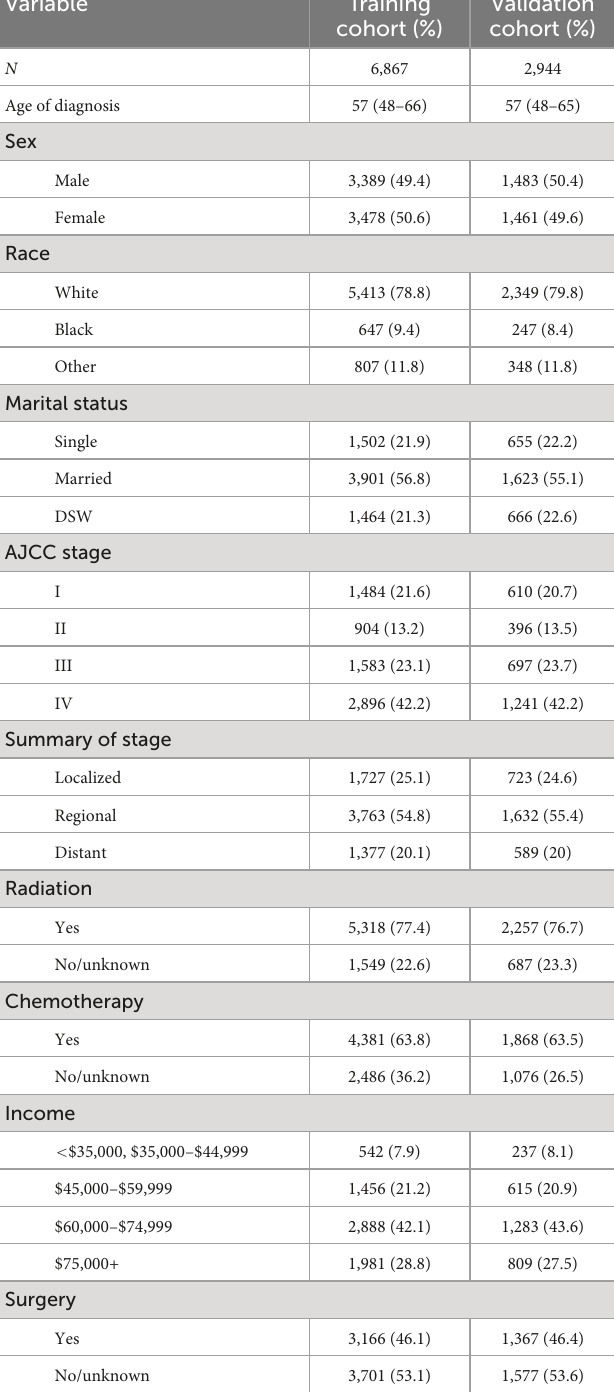
TABLE 1 Demographic and clinical characteristics of the two cohorts of patients. Variable